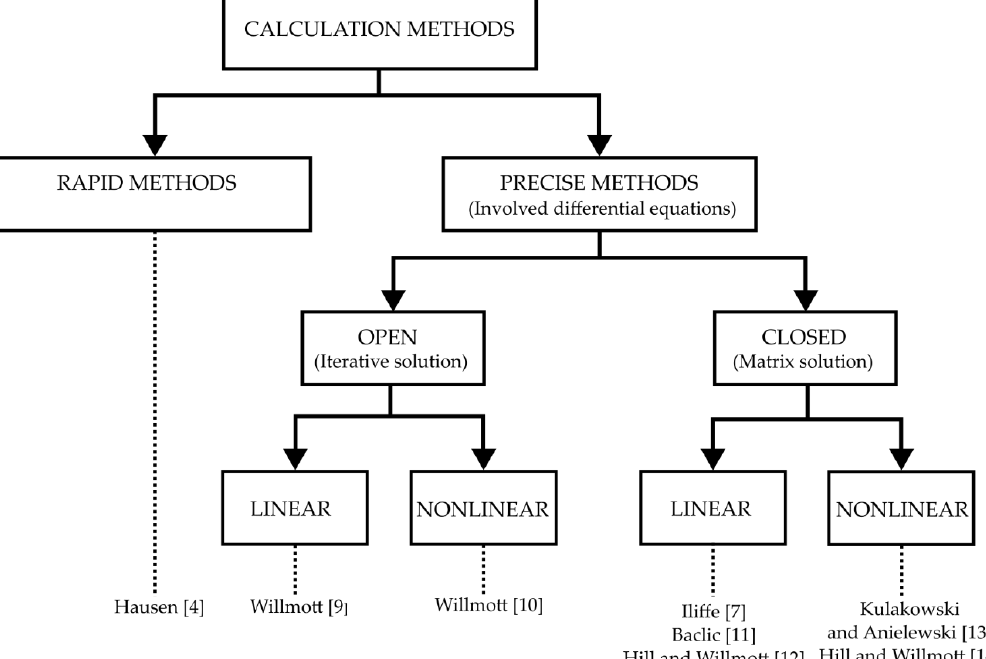
Figure 3. Diagram of calculation methods used for the solution of regenerative heat exchangers.